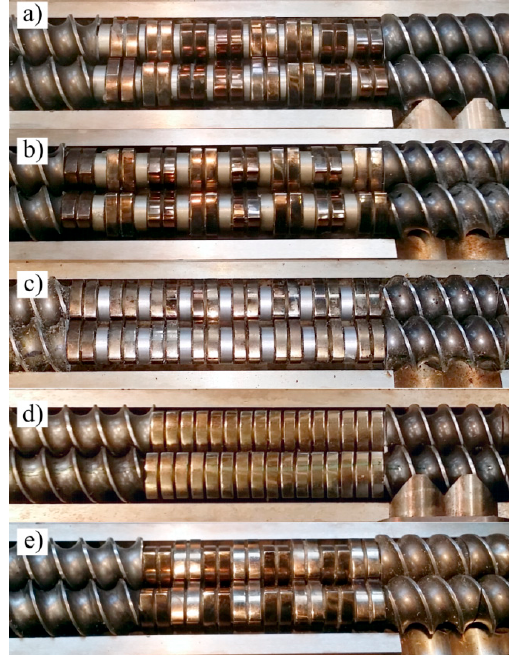
Figure 3. View of the design solutions of the test segment: ( a ) d = 2.5 mm α = 30°;( b ) d = 4.5 mm α = 60°;( c ) d = 4.5 mm α = 0°;( d ) d = 0.5 mm α = 0°; (e ) d = 0.5 mm α = 60°.